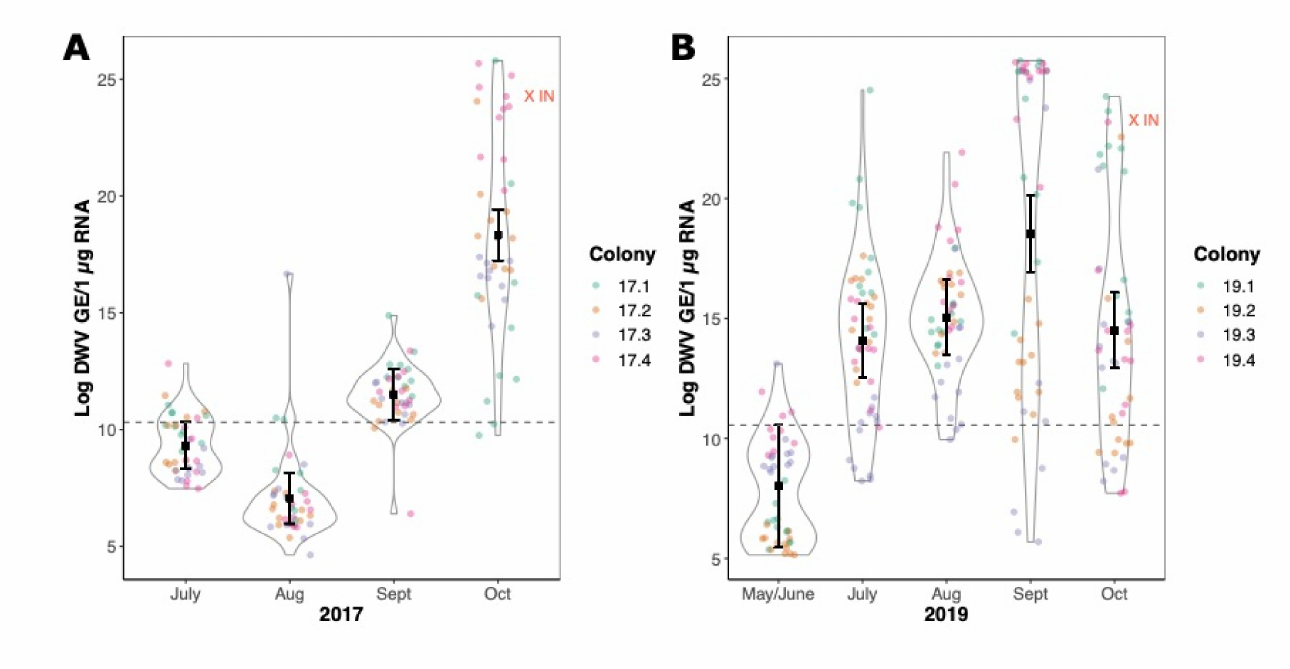
Figure 3. A violin plot showing the log DWV levels across multiple colonies and multiple seasons when colonies with low DWV and low Varroa levels were placed in a highly mite-infested apiary without treatment in 2017 ( A ) and 2019 ( B ). Only the emerging broods were sampled from the colonies, to ensure the bees sampled had not drifted from neighbouring colonies, so on occasions where no brood was available, samples were not taken or omitted from this analysis. Coloured circles represent individual honeybee samples from each colony ( n = 12). The black square represents the predicted mean from the mixed-effects model for each time point with corresponding 95% confidence intervals around the mean. Estimates and 95% confidence intervals above the dashed line indicate they are above the upper 95% confidence interval from the pre-treatment timepoint. Red crosses represent the mean log DWV from an infested neighbouring (IN) colony in the apiary, which was sampled in the same manner as the naïve colonies at the end of each season (2017 n = 10; 2019 n = 12). Both the simple linear models and the mixed models indicated that time point was a significant predictor of log DWV in sampled bees in both 2017 and 2019 (Tables S3 and